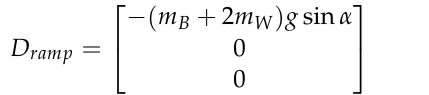
The above disturbance certainly does not satisfy the matching condition because it does not exist in the column space of the input matrix. In other words, it cannot be expressed as a linear combination of the column vectors of B in Equation (1).